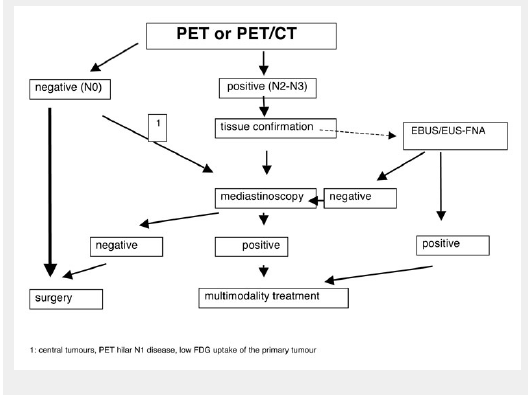
Algorithm (De Leyn P, Lardinois D, Van Schil P, Rami-Porta R, Passlick B, Zielinski M, Waller D, Lerut T, Weder W. ESTS guidelines for preoperative lymph node staging for NSCLC. Eur J Cardiothorac Surg